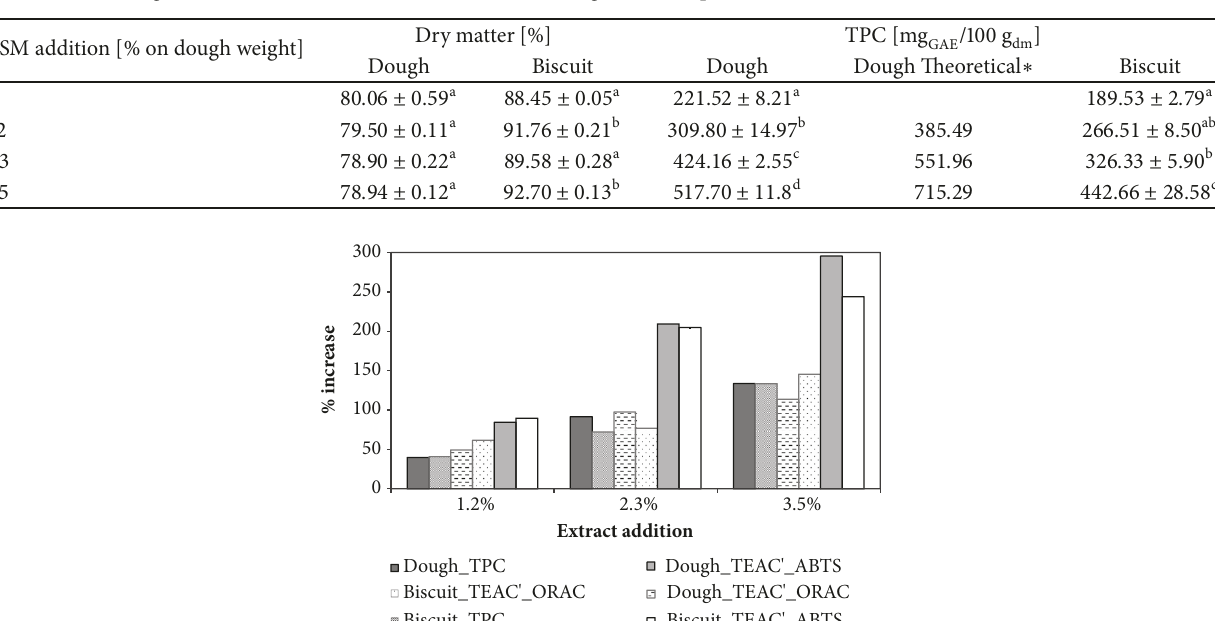
Table 2: Dry matter and total phenols content (TPC) of doughs and biscuits at different levels of grape skin extract encapsulated into maltodextrins (GSM) enrichment. Values are means ± SD (n = 3). The same superscript letter under each column indicates the means are not statistically different according to analysis of variance (ANOVA) and Tukey’s post hoc test (p < 0.01). ∗ TPC theoretical value based on the TPC of control dough, extract addition level and extract TPC. GAE: gallic acid equivalents.